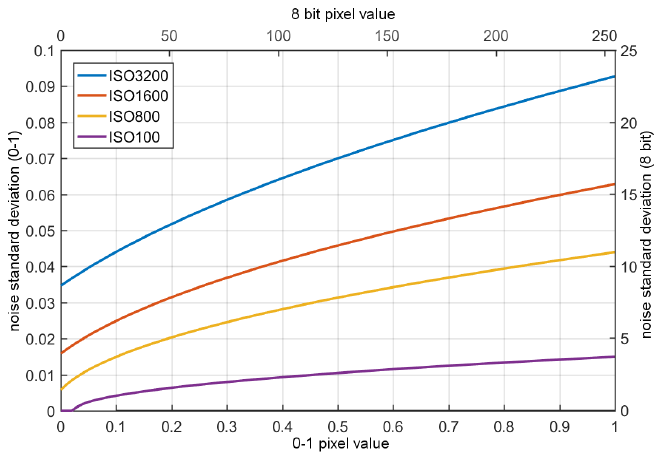
Figure 11. Real Gaussian–Poisson real noise parametrization for selected ISO